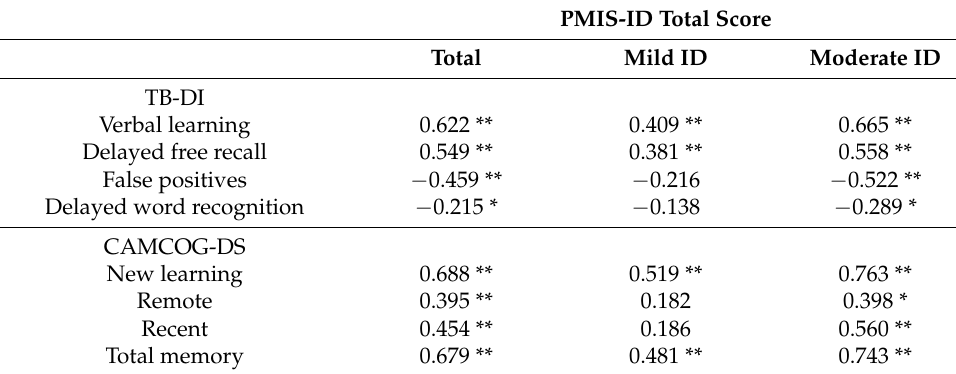
Table 6. Convergent validity values by groups.